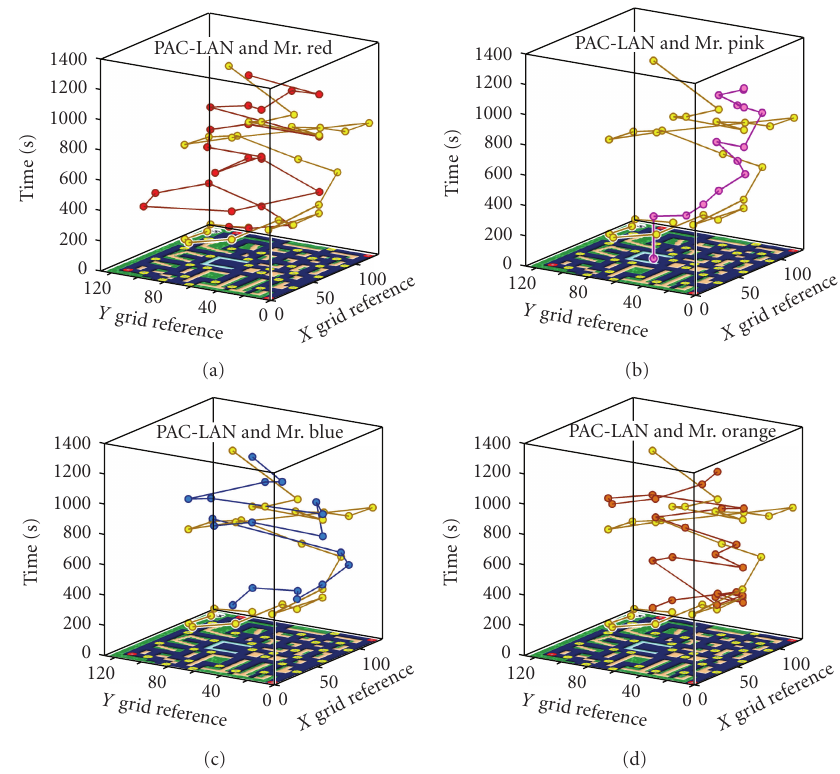
Figure 5: Space-time paths of PAC-LAN compared to each of the four